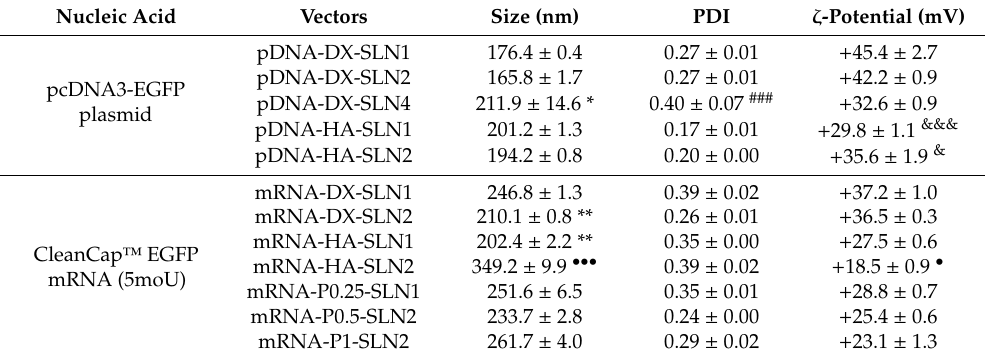
Table 2. Physical characterization of SLNs-based